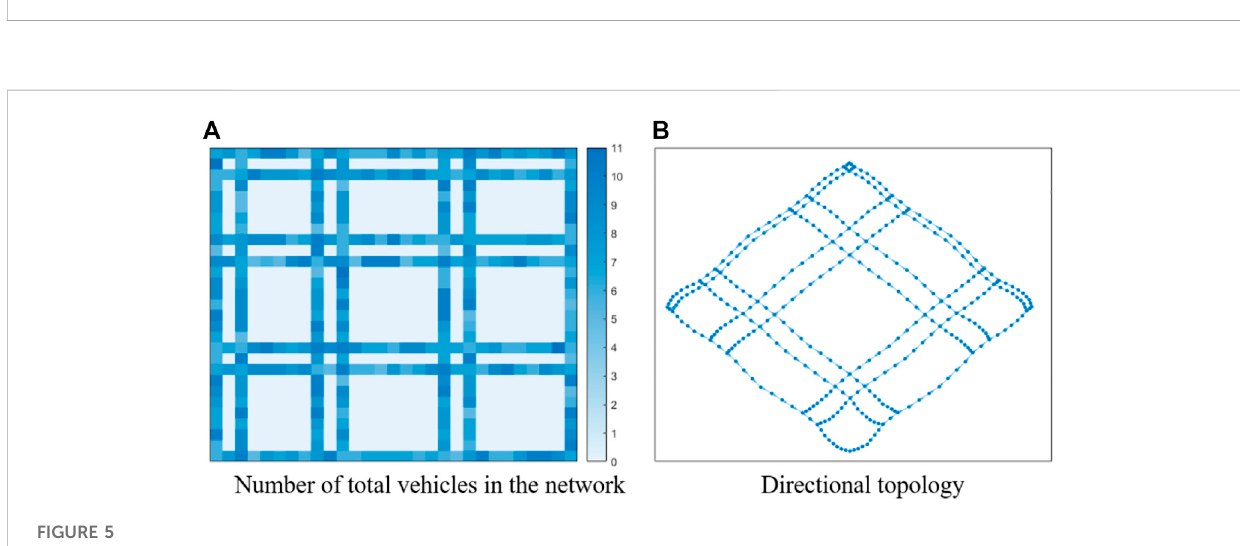
FIGURE 5 Speci fi c parameters of the traf fi c